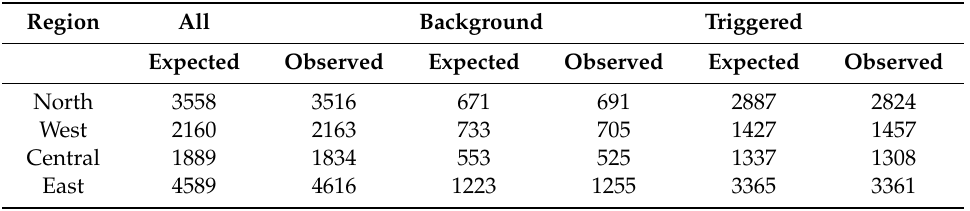
Table 12. Total number of expected and observed events, background events and triggered events for each region. The expected numbers of events are calculated using (12) to (14). Region All Background Triggered Expected Observed Expected Observed Expected